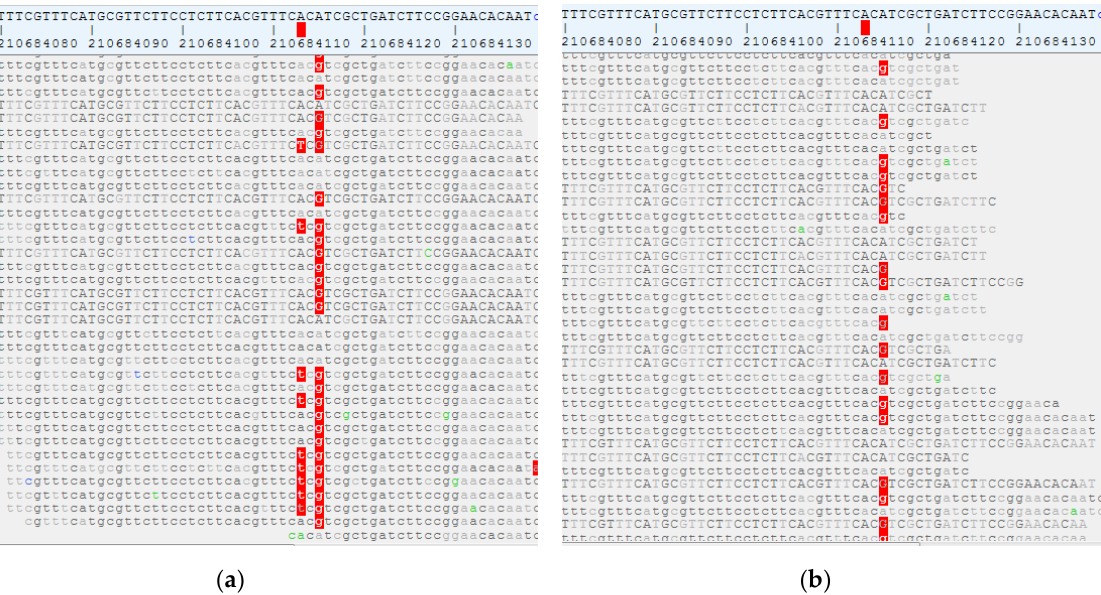
Figure 2. Somatic c.2138 T>A (p.Val713Glu) mutation in KCNH1 in focal cortical dysplasia (FCD) tissue ( a ) detected by exome sequencing. Please note the virtual absence of the mutation at genomic position 1:210684113 A>T (position of the red cursor) in healthy brain tissue from the same patient ( b ) and in the blood sample (not shown).